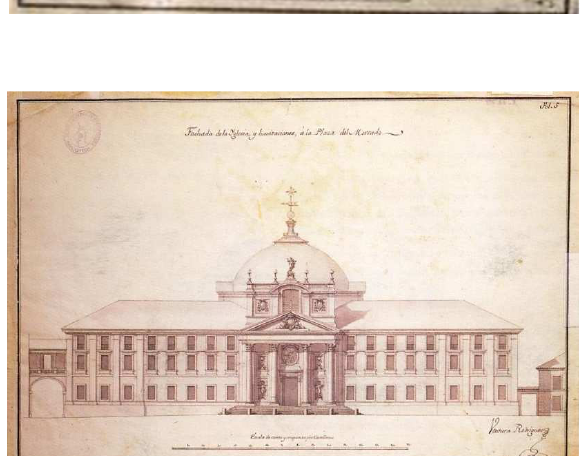
Figure 4: Principal floor plan and main facade of the